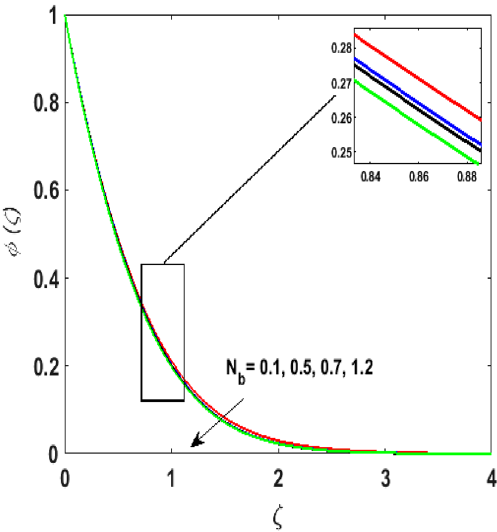
Figure 19. φ(ζ) for various N b